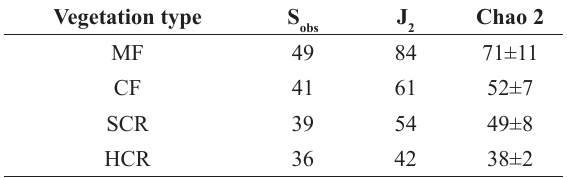
Observed (S ) and estimated plant species richness obs (second–order Jackknife, J , and Chao estimators) for 2 each of the four vegetation types sampled on lateritic canga at Serra Sul, state of Pará, Brazil( Error term for Chao 2 is standard deviation of the bias corrected